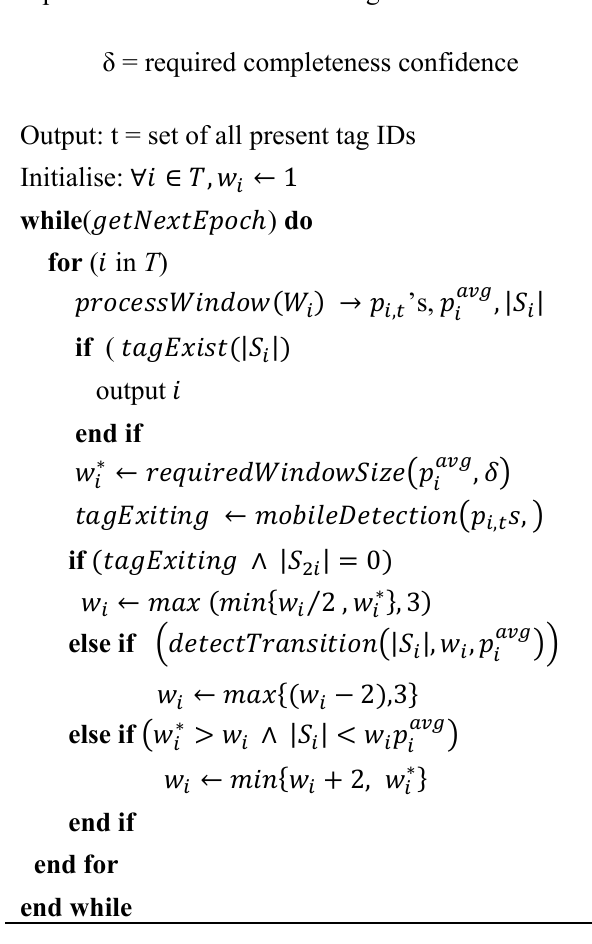
Figure 2. WSTD individual tag cleaning